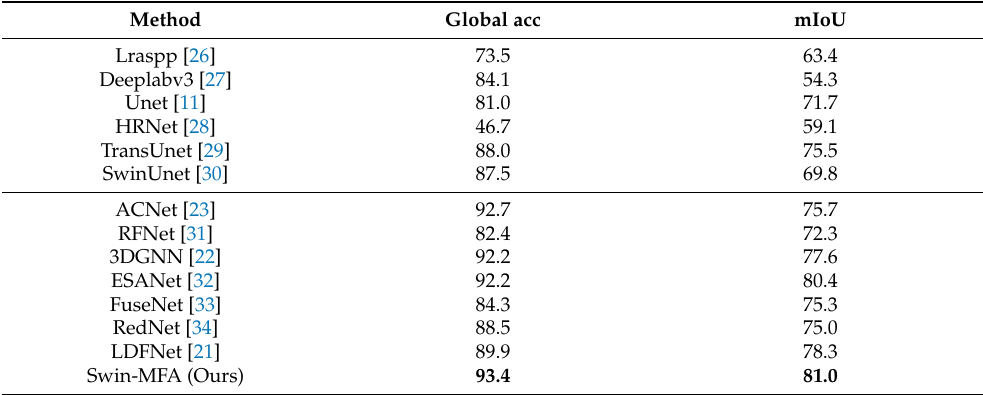
Table 3. The mIoU and global accuracy results of the comparison